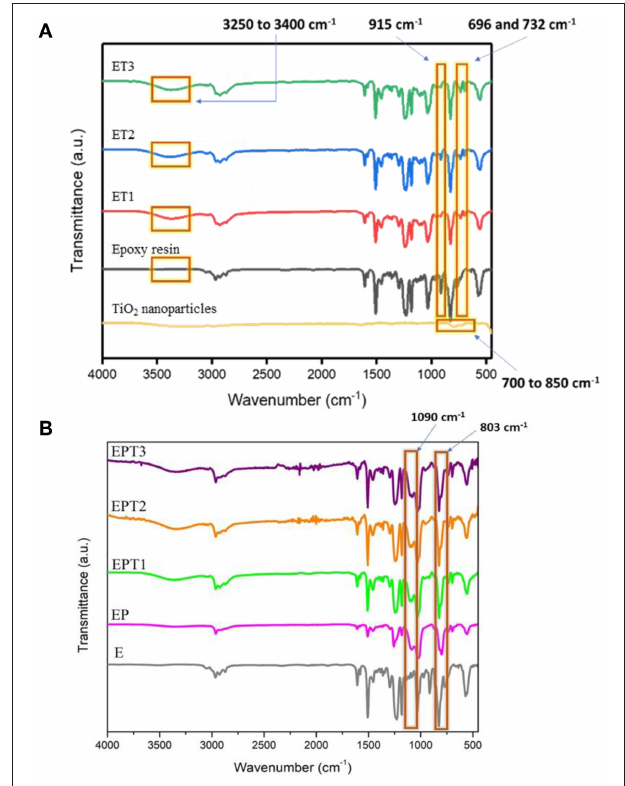
FIGURE 1 | FTIR spectrum for (A) TiO 2 nanoparticles, epoxy resin, and all developed epoxy-TiO 2 nanocomposite coating systems and (B) for E, EP, EPT1, EPT2, and EPT3 coating